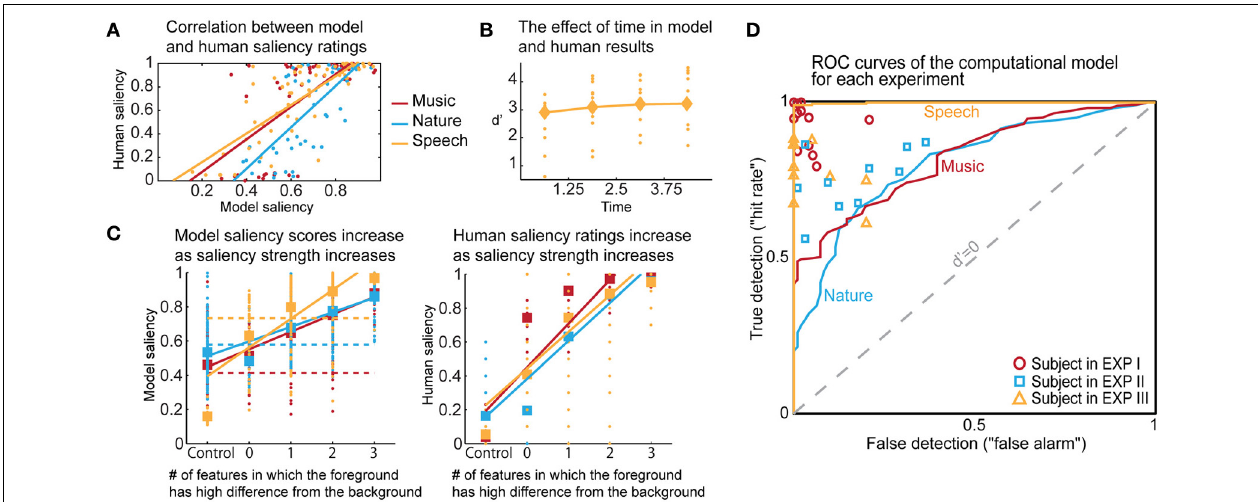
FIGURE 6 | Comparisons of human and model results based on saliency ratings and detection performance. (A) Correlation between averaged model saliency scores and human saliency ratings shown for all experiments. Averaging is performed between repeated experimental cases, and also between subjects for the human ratings. (B) The time trend that emerged in the model results for Experiment III. Diamonds show the d (cid:2) for each quadrant in model results, and dots represent the human responses. We observe a similar trend as in Figure 2B . (C) We show that as saliency increases, the model produces higher saliency scores. This is along the same lines with human results. Control trials have no foreground token; there is no salient event during the scene. Feature level 0 on the x -axis corresponds to a foreground token with low level of saliency. As an example, for Experiment III, this corresponds to no difference in pitch or timbre, but a 10db difference